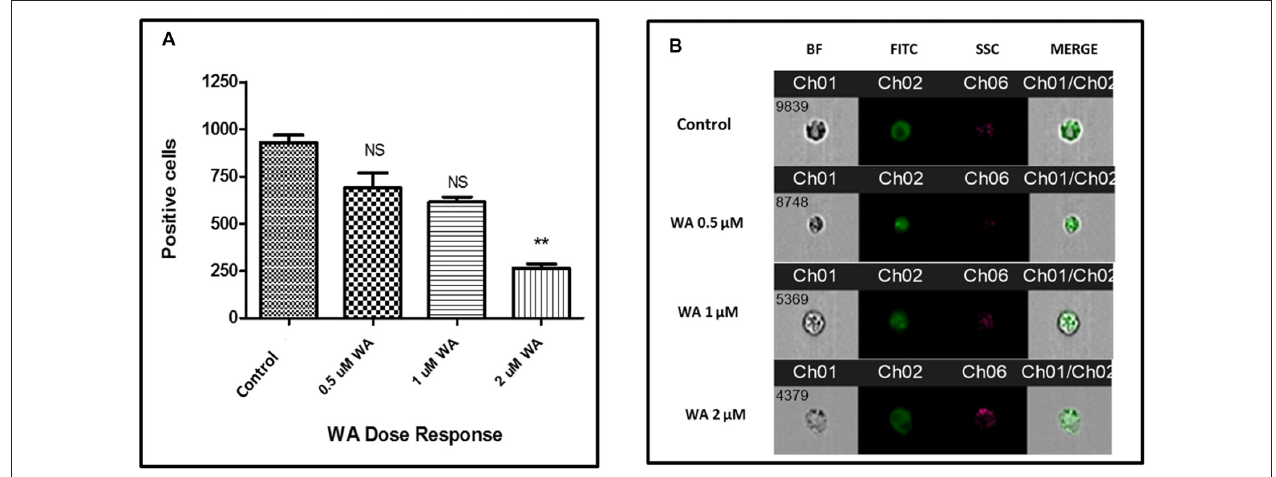
FIGURE 3 | WA inhibits A β production: single cell flow Cytometry was used to identify the expression of A β 1–40 protein in SH-APP cells after treatment with different concentration of WA. (A) Bar graph representing the mean ± standard error of percent of mean fluorescence intensity. (B) Representative single cell images. We have observed significantly reduced A β with WA exposure dose dependently ( n = 3; ∗∗ p ≤ 0.01; NS: Non